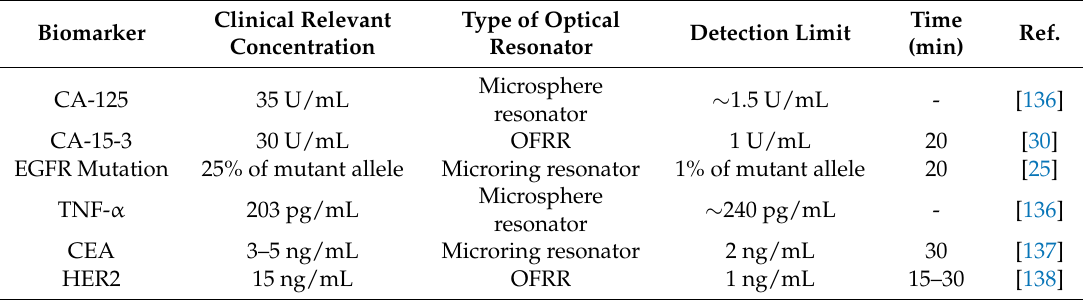
Table 3. Known biomarker with clinical relevant concentration and reported detectable concentration with optical